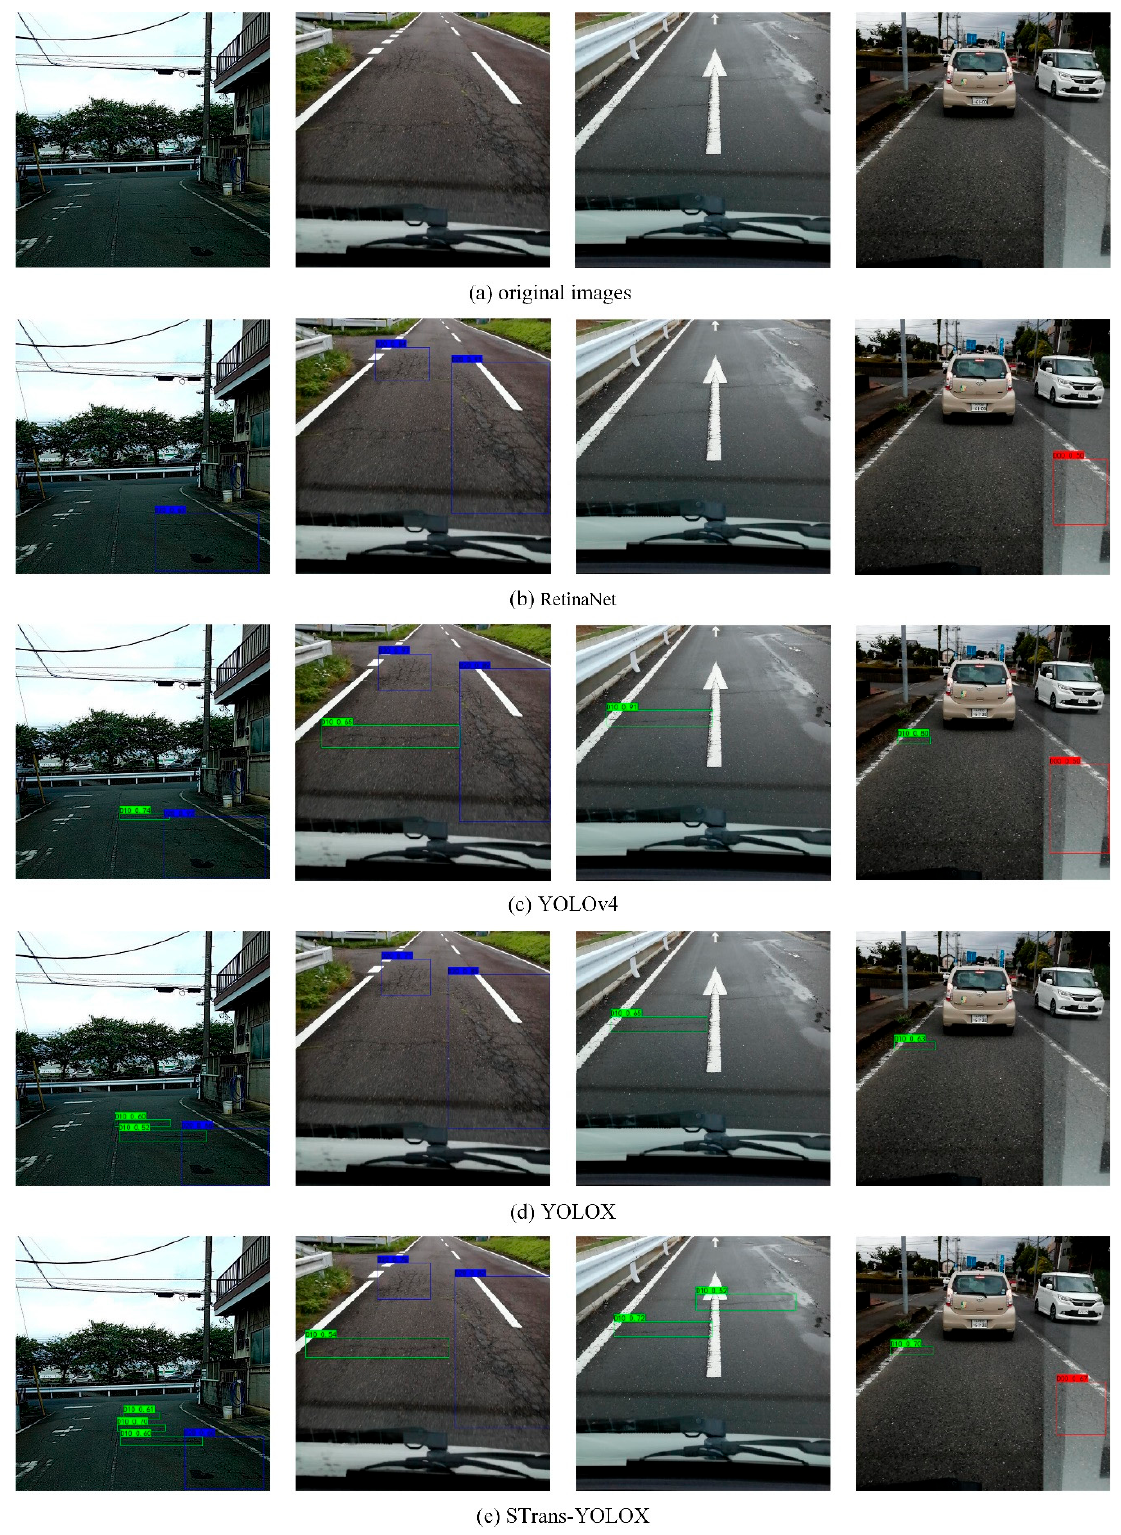
Figure 8. The visual detection results of different models.